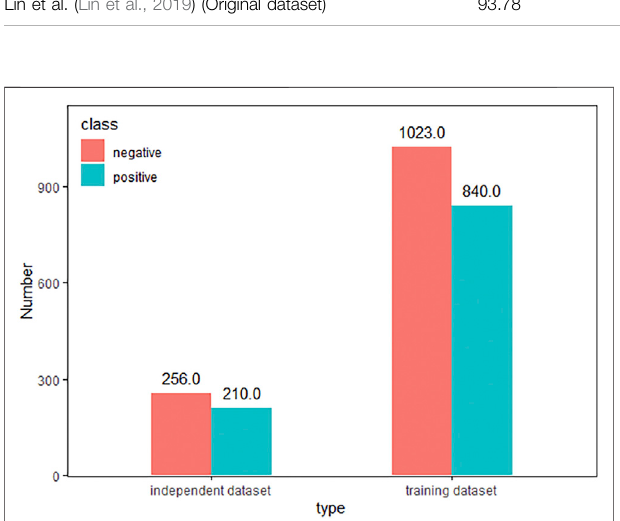
Figure 6 . The independent test set using the DrugHybrid_BS model can accurately predict 96.5665% of the potentially druggable protein.